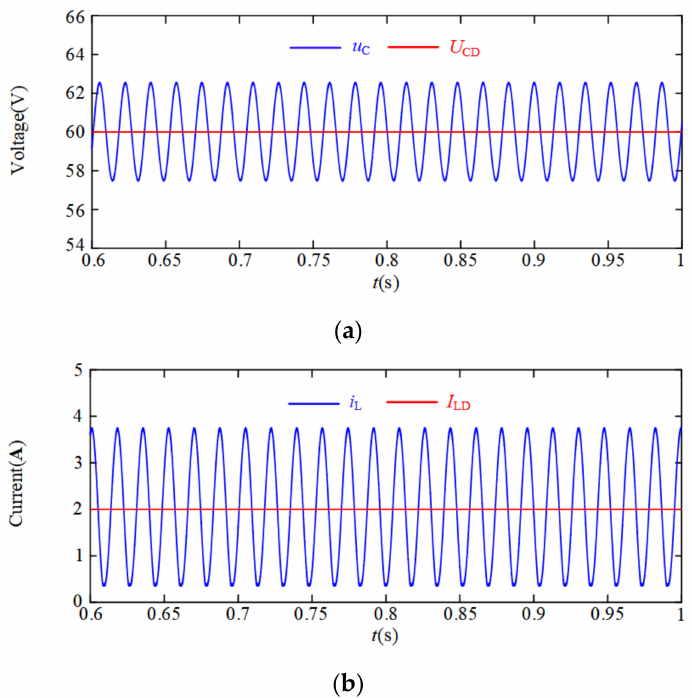
Figure 5. Voltage and current of DDBC under open control. ( a ) output voltage and desired output voltage; ( b ) inductor current, CPL current, desired inductor current, and CPL